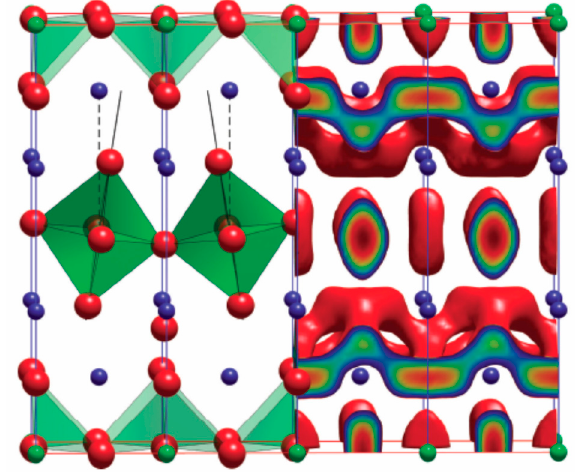
Figure 2. In the left part of the figure the tetragonal Pr 2 NiO 4 + δ where O is in red, NiO 6 octahedra in green and Ni in blue (c-axis is the vertical axis). The right part of the figure represents the isosurface connecting the O di ff usion sites in the a-b plane as derived using molecular dynamics at 1100 K and δ = 0.09875 Reproduced by permission from the Owner Societies